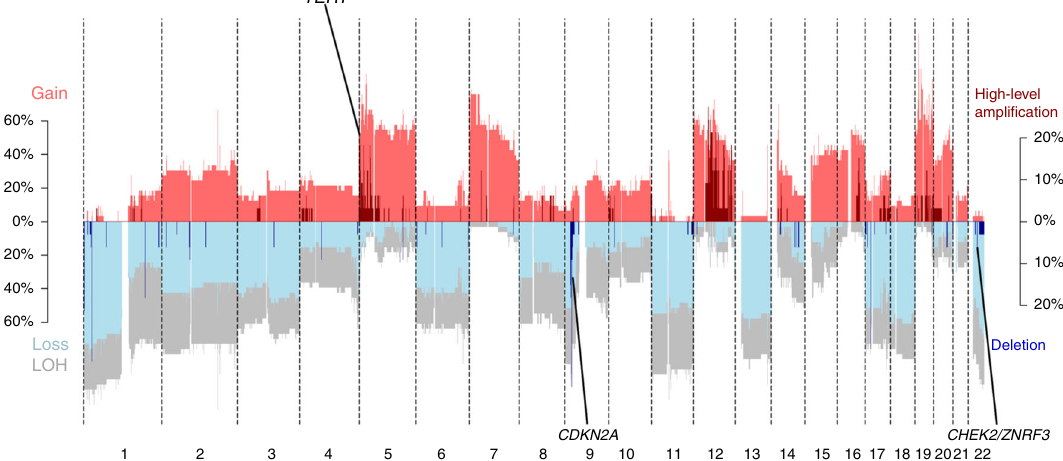
Fig. 4 Copy number variation in metastatic tumors. High-level ampli fi cations and deletions in metastatic ACC tumors. Regions of TERT , CDKN2A , and CHEK2/ZNF3 that are common in primary tumors and observed in metastatic tumors are highlighted. Red and blue represent chromosomal gain and loss,